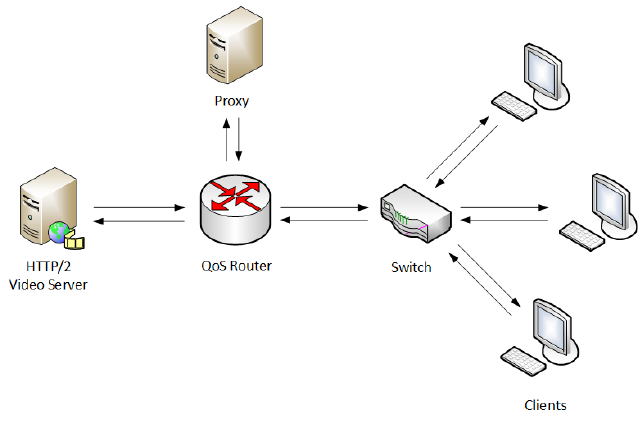
Figure 4. Experiment